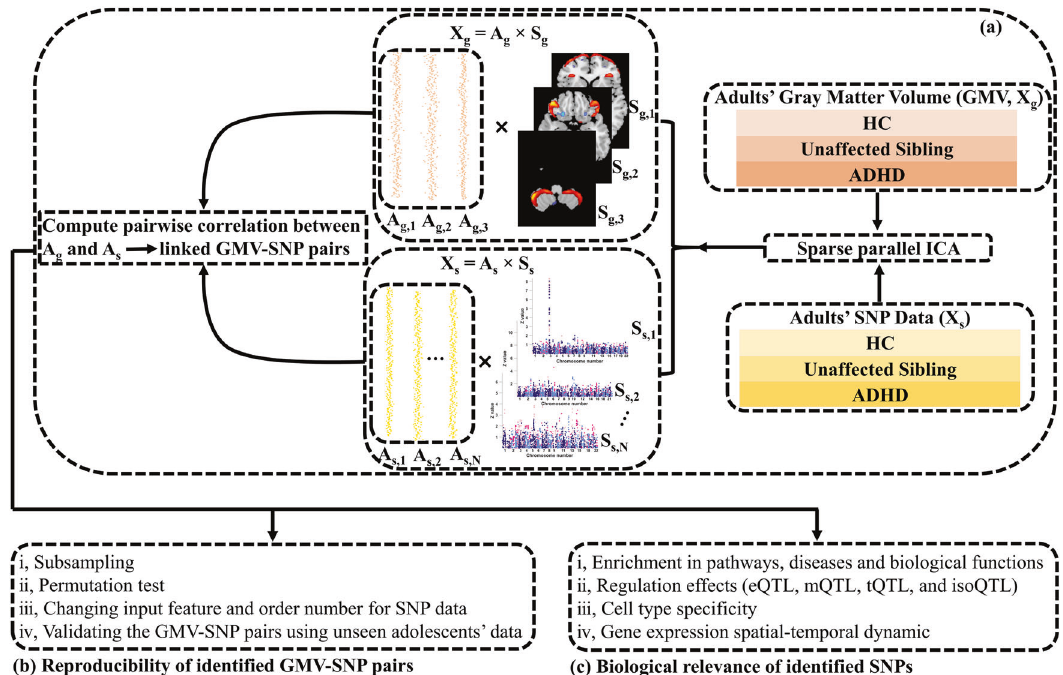
Fig. 1 Analysis pipeline of the study. a Applying spICA to GMV and SNP data of 341 unrelated adult participants to identify linked GMV-SNP pairs. b Examining the stability and replicability of the identi fi ed GMV-SNP pairs by various robustness analyses and external validation. c Performing a series of downstream analyses to investigate the biological relevance of the identi fi ed